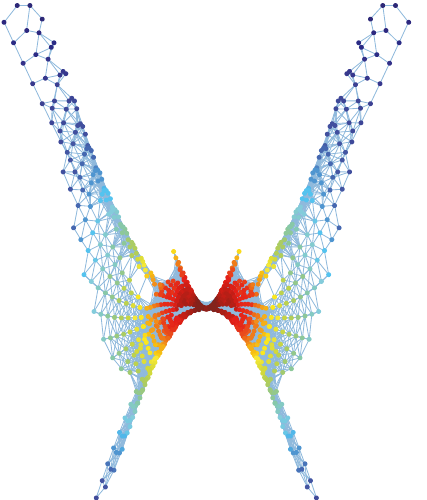
Figure 6: Spatial network constructed from the distribution of pointsinaunitsquareaccordingtothetransform 𝑇 3 usingaconnec- tion radius 𝑅 = 0.1 with 𝑛 = 2000 points and coloring the nodes according to their closeness